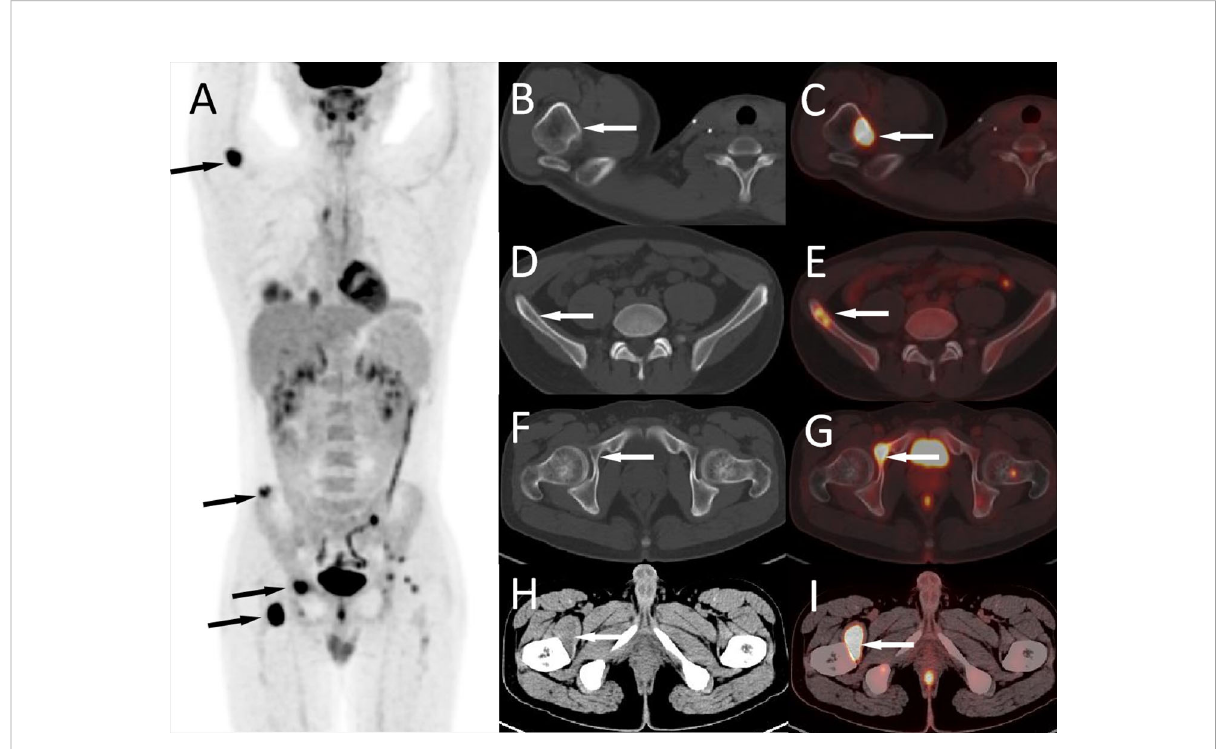
FIGURE 3 The patient ’ s 18 F-FDG PET/CT at 5 years after operation; the maximum intensity projection fi gure showed multiple FDG concentration foci throughout the body ( A , arrows). Axial fi gures showed that the right humerus ( B , CT; C , PET/CT fusion), ilium ( D , CT; E , PET/CT fusion), and acetabulum ( F , CT; G , PET/CT fusion) can be seen with iso-density or slightly hypodense bone destruction areas with high radioactive uptake (arrows). Moreover, a hypodense mass with FDG accumulation was seen in the right iliopsoas muscle ( H , CT; I , PET/CT fusion,